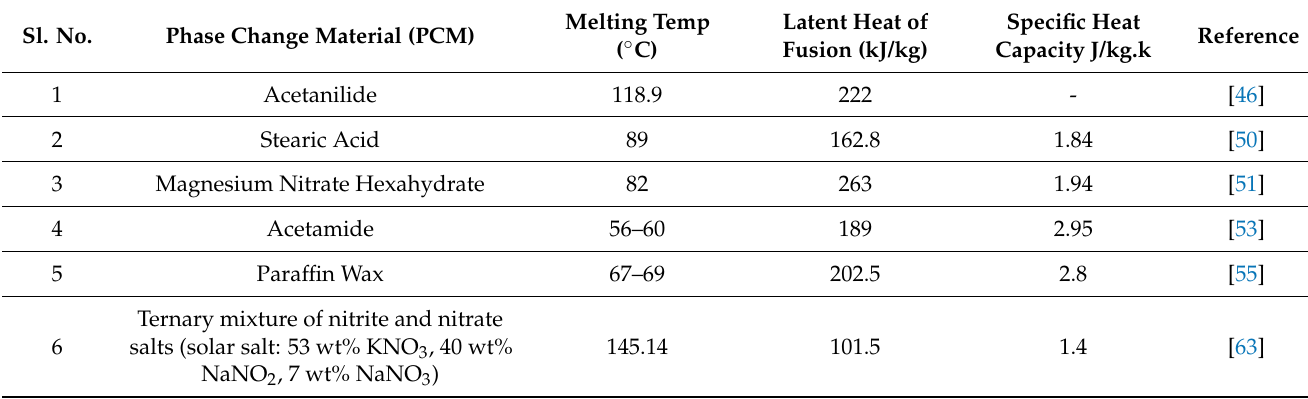
Table 2. Thermophysical properties of the